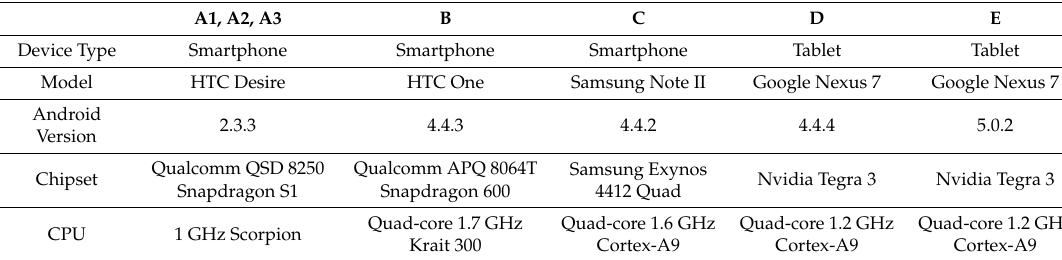
Table 6. Devices used in the evaluation of the prototype.